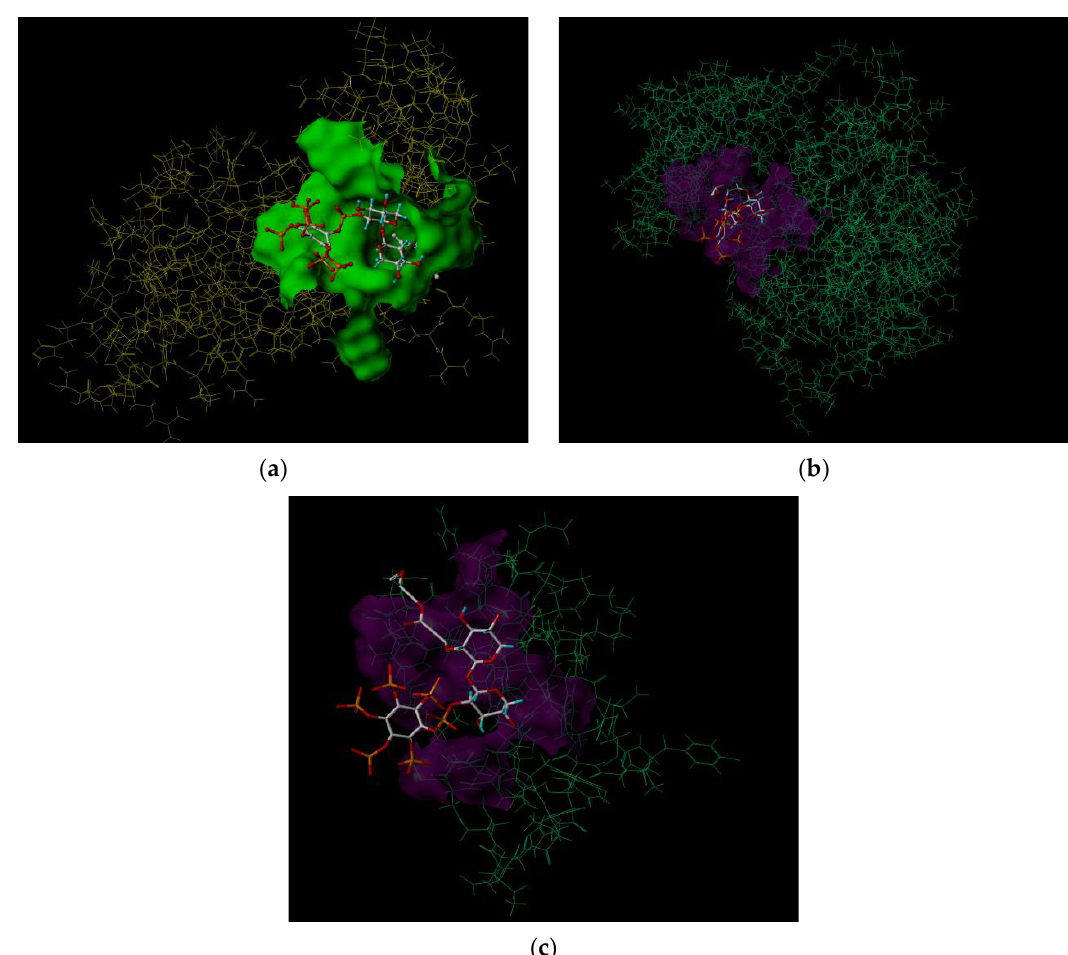
Figure 9. Images of the GMA BX-PA link to the amino acid residue. ( a ) An image of the GMA BX-PA link to the amino acid residue of 5XNV. ( b ) An image of the GMA BX-PA link to the amino acid residue of 2EB2. ( c ) An image of the GMA BX-PA link to the amino acid residue of 2M6N.